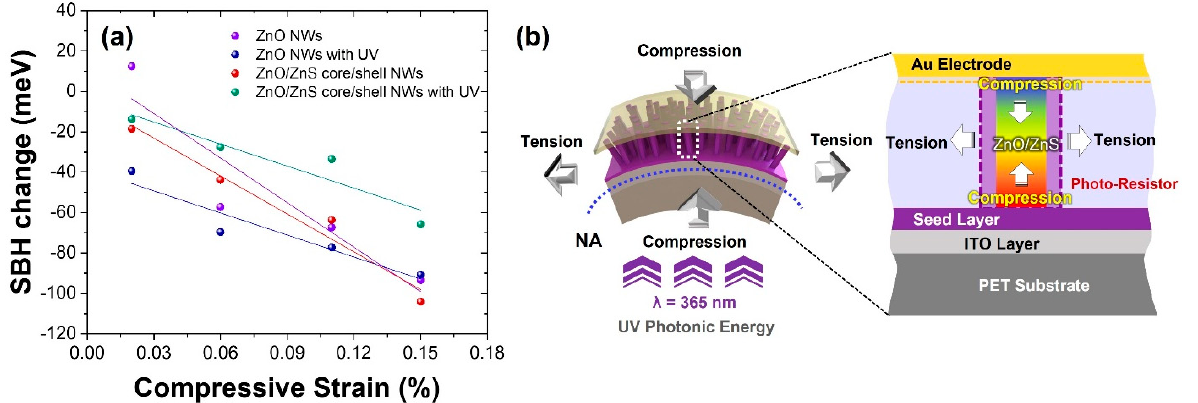
Figure 5. ( a ) The calculated Schottky barrier height (SBH) change as a function of the applied external compressive strain at 5 V. ( b ) Schematic illustration of vertically grown ZnO/ZnS core/shell NW devices, showing the direction of the applied strains.